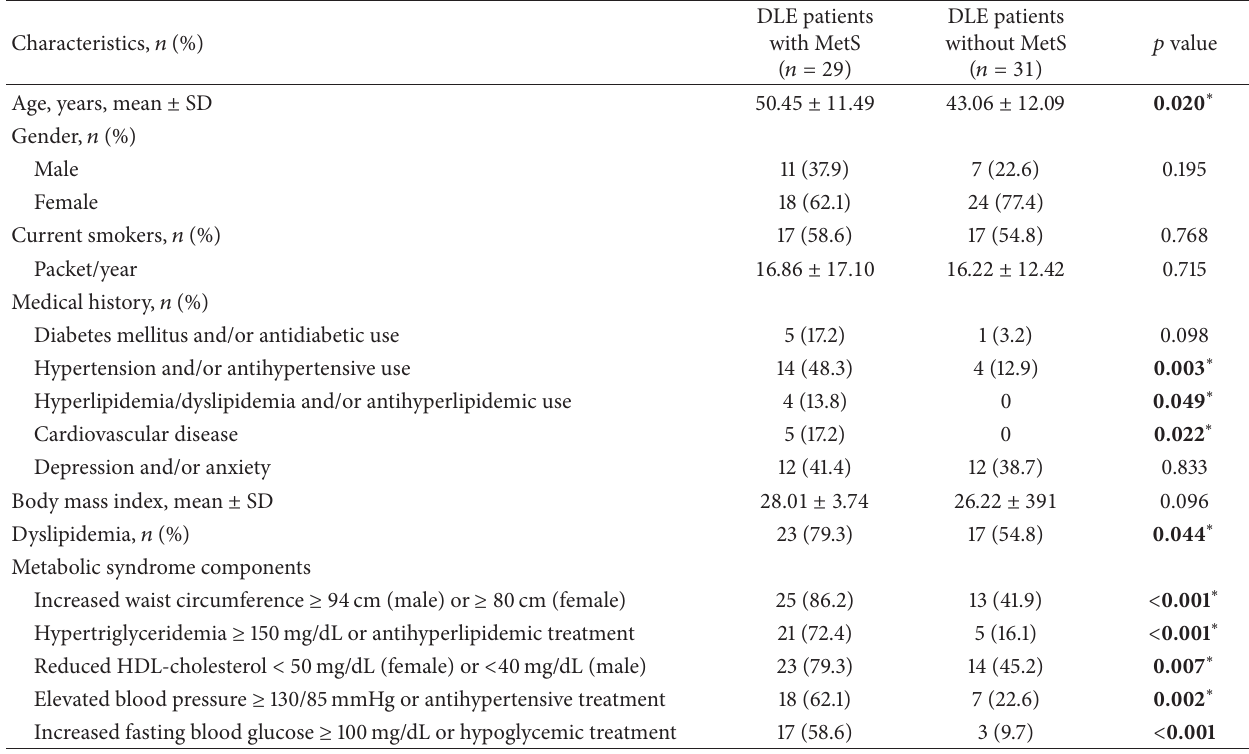
Table 2: Comparison of sociodemographic features, medical history findings, and metabolic syndrome components in DLE patients with and without metabolic